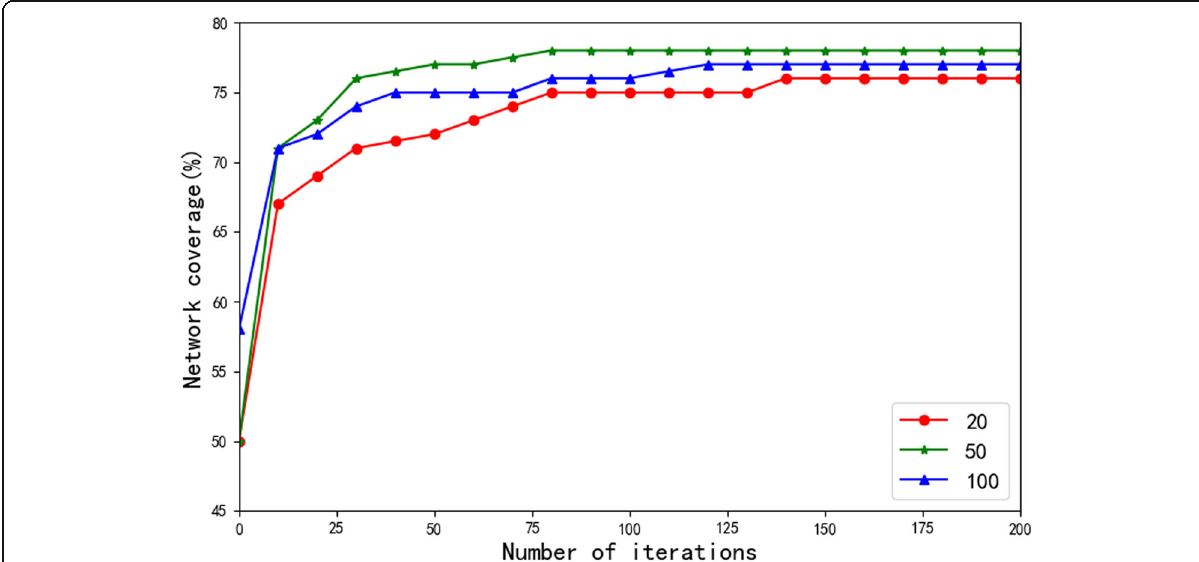
Fig. 2 Comparison of different coverage rates of population number. Figure 2 shows the comparison of the different coverage rates of the population